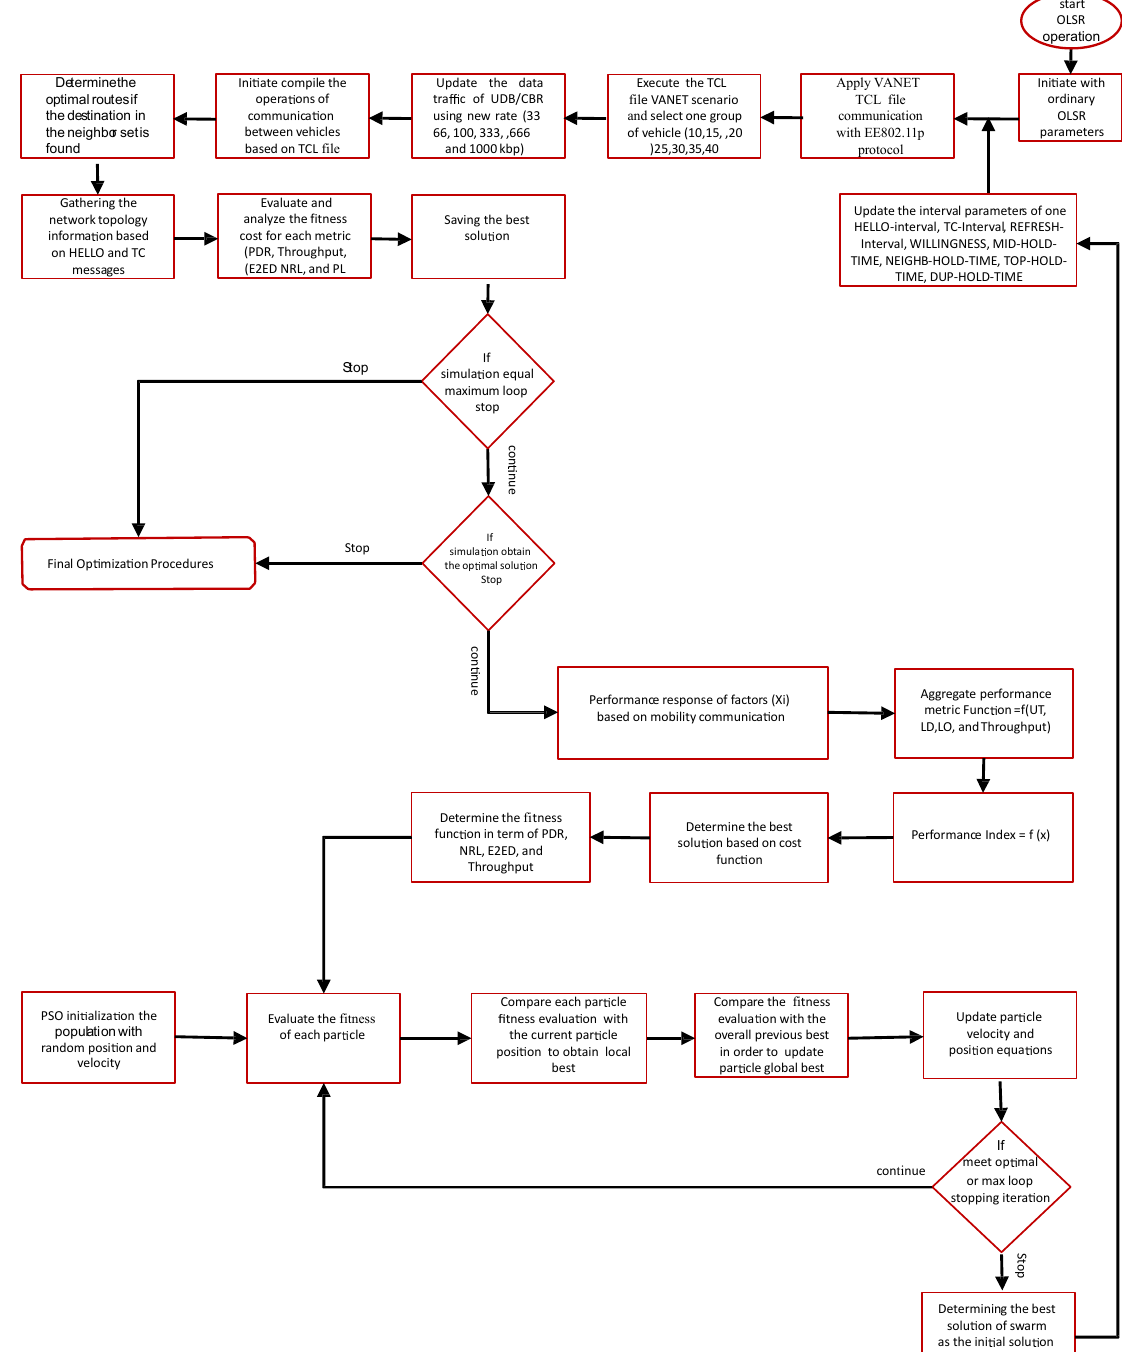
Figure 3. Simulation Flow Diagram of Optimization